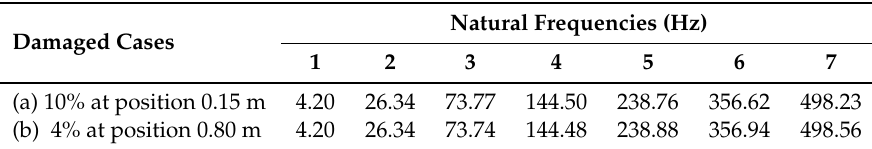
Figure 7. Single-damaged cases set in 2D beam, where positions and stiffness reduction are: ( a ) 0.15 m with 10% ; ( b ) and at 0.8 m with 4%. Table 3. Numerically measured natural frequencies of single damaged cases (a) and (b) with parameters of position and